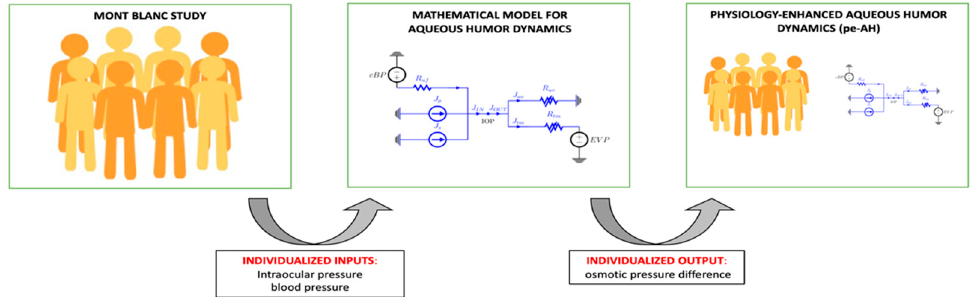
Figure 3. Schematic of the physiology-enhanced aqueous humor ( pe-AH ) analysis. Starting from clinical data ( left ) of intraocular pressure (IOP) and blood pressure (BP) from the Mont Blanc Study, the mathematical model of aqueous humor dynamics ( center ) was used to estimate the value of the osmotic pressure difference (OPD) and enhance the dataset ( right ).